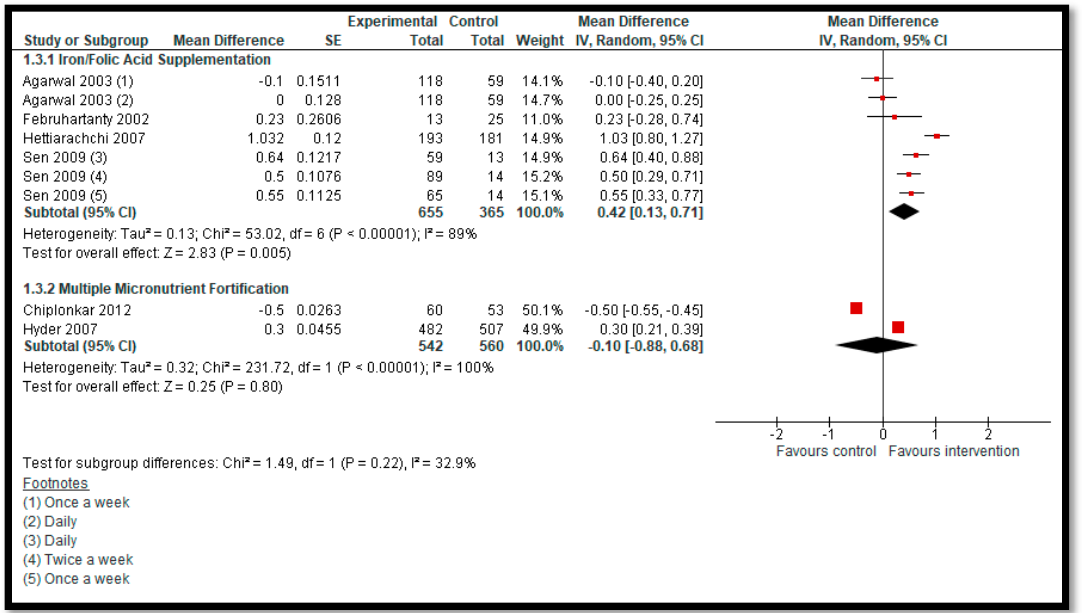
/ fortification on